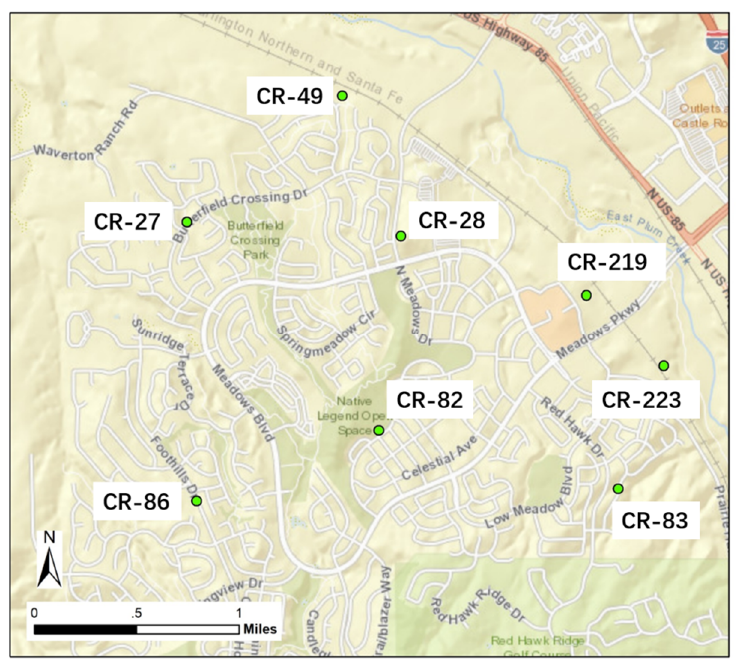
Figure 1. Well locations at the Meadows Pumping Center in Castle Rock, CO, USA.